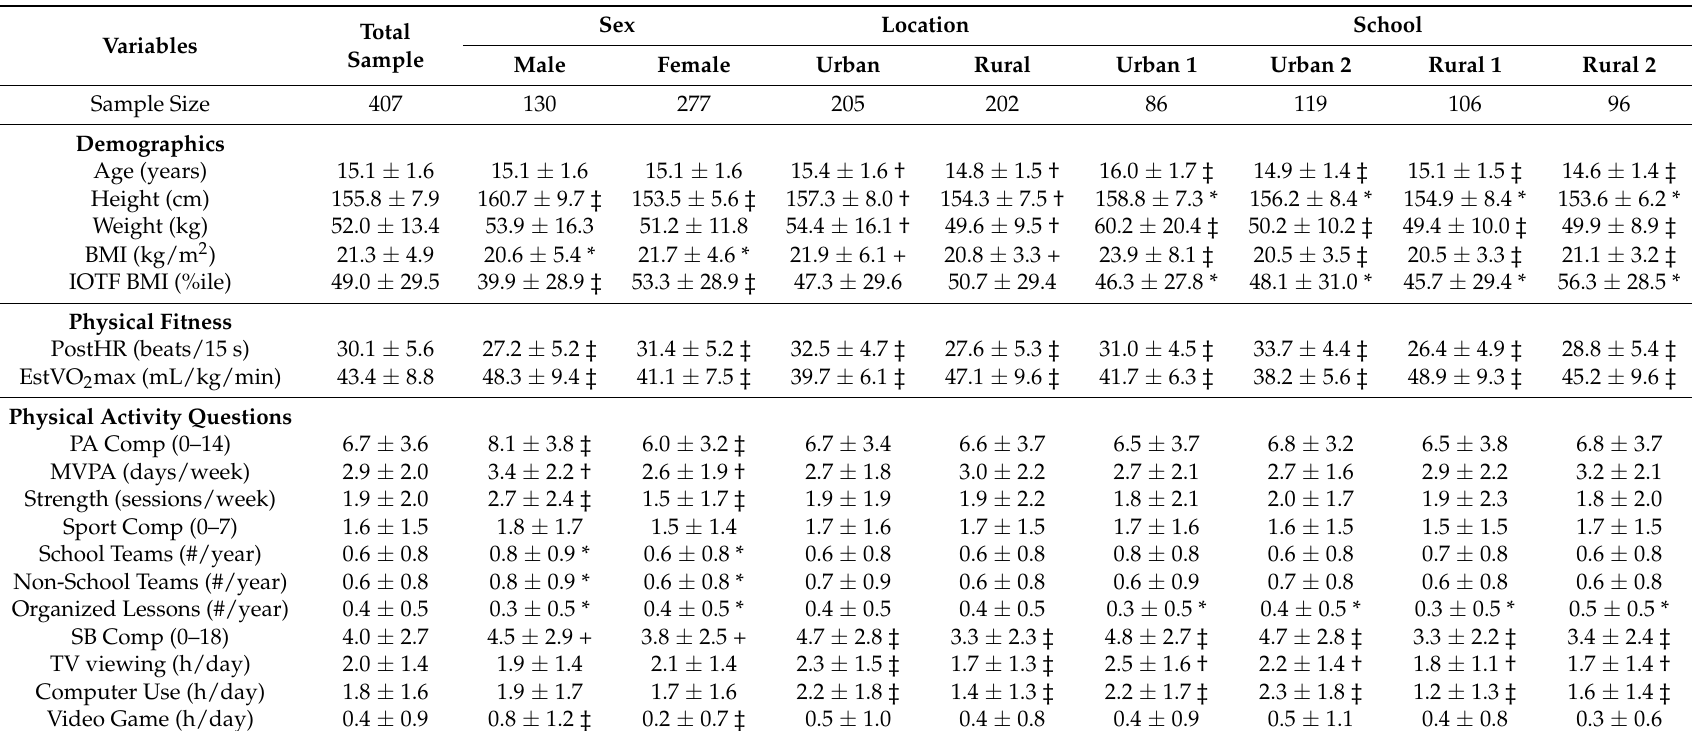
Table 1. Participant characteristics overall and by sex, location, and school. Means ±